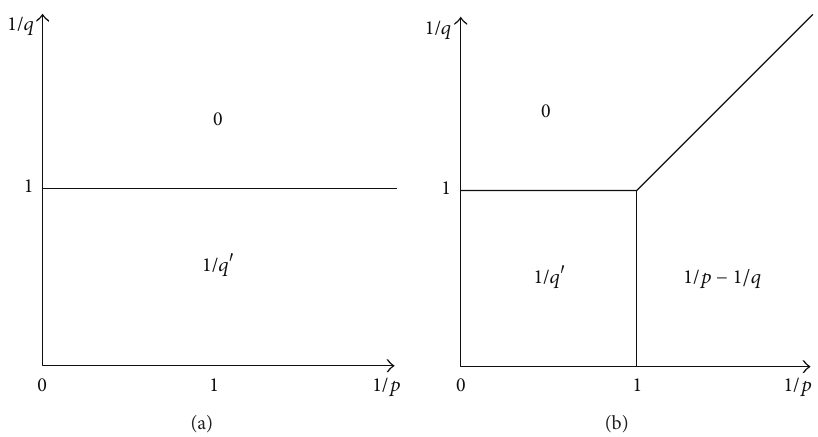
Figure 1: Comparison between the critical regularity index 𝑠 for T 𝑊 𝑝,𝑞 𝑠+𝜖 ( R 𝑛 ) = 𝑊 𝑝,𝑞 ( R 𝑛−1 ) (a) and T 𝑀 𝑝,𝑞 𝑠+𝜖 ( R 𝑛 ) = 𝑀 𝑝,𝑞 ( R 𝑛−1 )